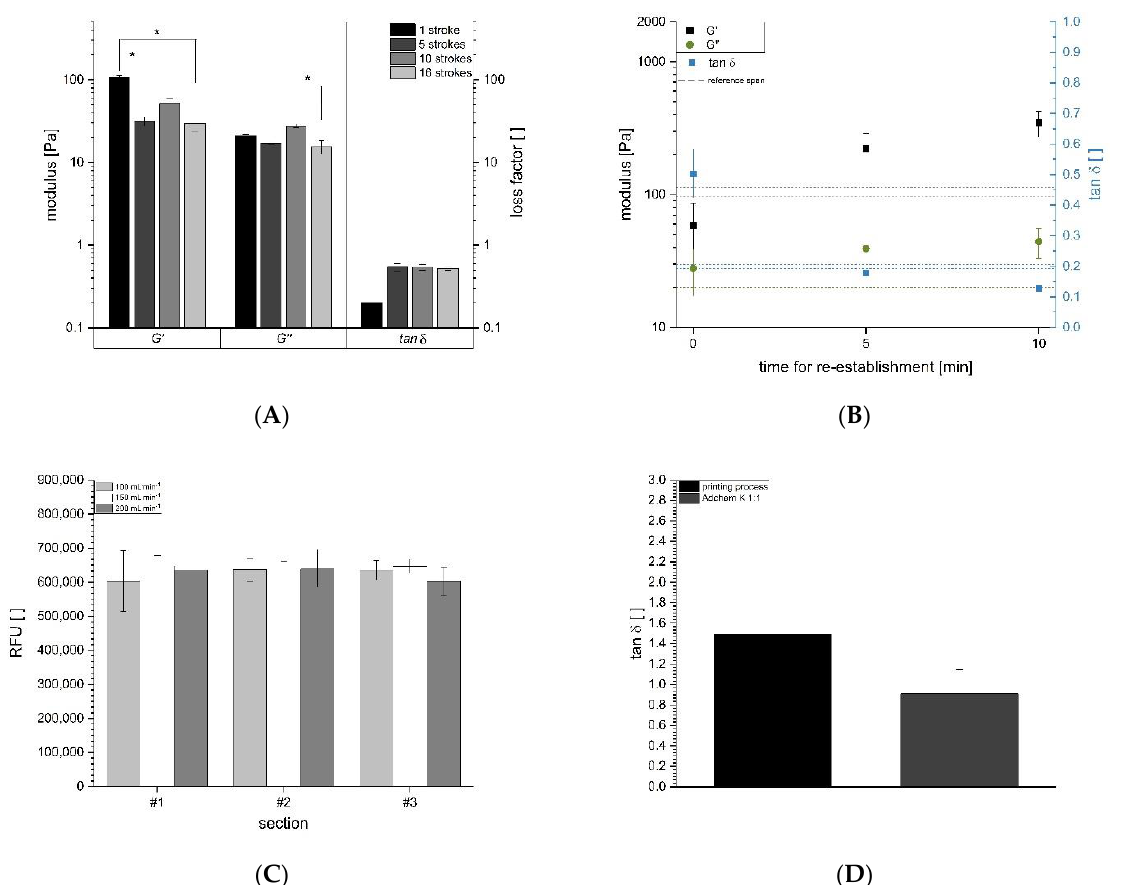
Figure 4. Optimization of the mixing process by applying the requirements profile (Table 2) to the Adchem 1:1 system at 28 °C. ( A ) Rheological assessment of the impact of pipetting strokes on the gelatin solution ( n = 3; Kruskal–Wallis test * p < 0.1). ( B ) Time-dependent re-establishment of the gelatin solution after 16 strokes compared with one stroke ( n = 3). ( C ) Analysis of homogeneity using fluorescein for the three mixing sections ( n = 3) with different syringe pump settings. ( D ) Rheological properties after mixing ( n = 6) relative to an established printing process (black column).